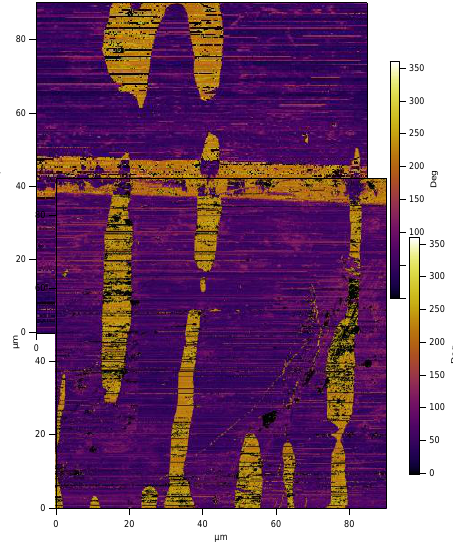
Figure 12. Vertical piezoresponse force microscopy on barium titanate single crystal showing c+ and c− domains with 180° domain boundaries (90 µm width region).